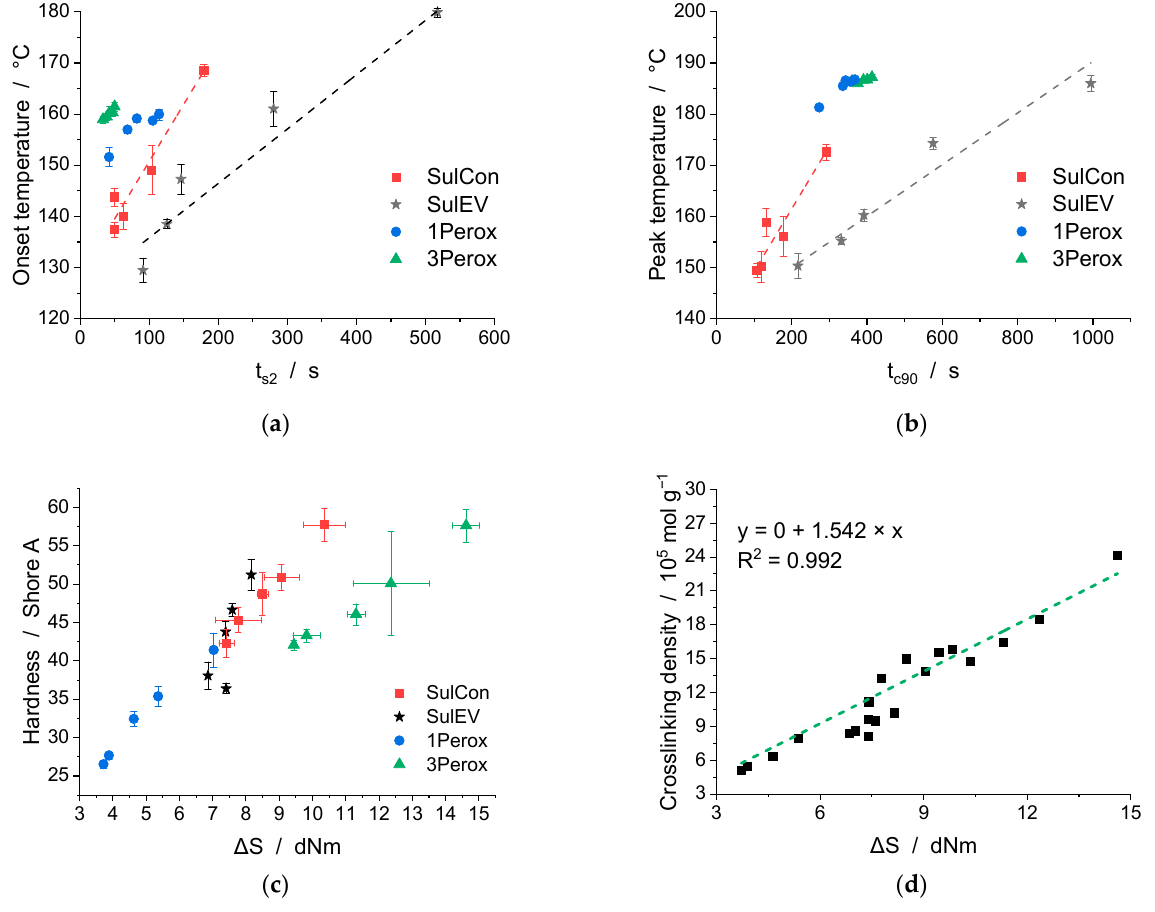
Figure 6. Correlations between the different methods and results: ( a ) onset temperature (DSC) over scorch time (MDR), ( b ) peak temperature (DSC) over optimum curing time (MDR), ( c ) Shore A hardness over Δ S (MDR), and ( d ) crosslinking density (swelling) over Δ S (MDR).